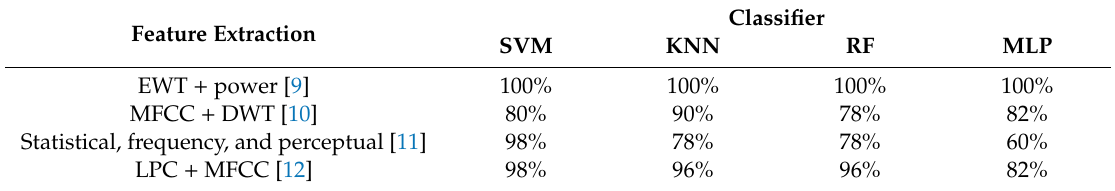
Table 6. Accuracy results of synthetic signals, using the trained models proposed in articles [9–12].